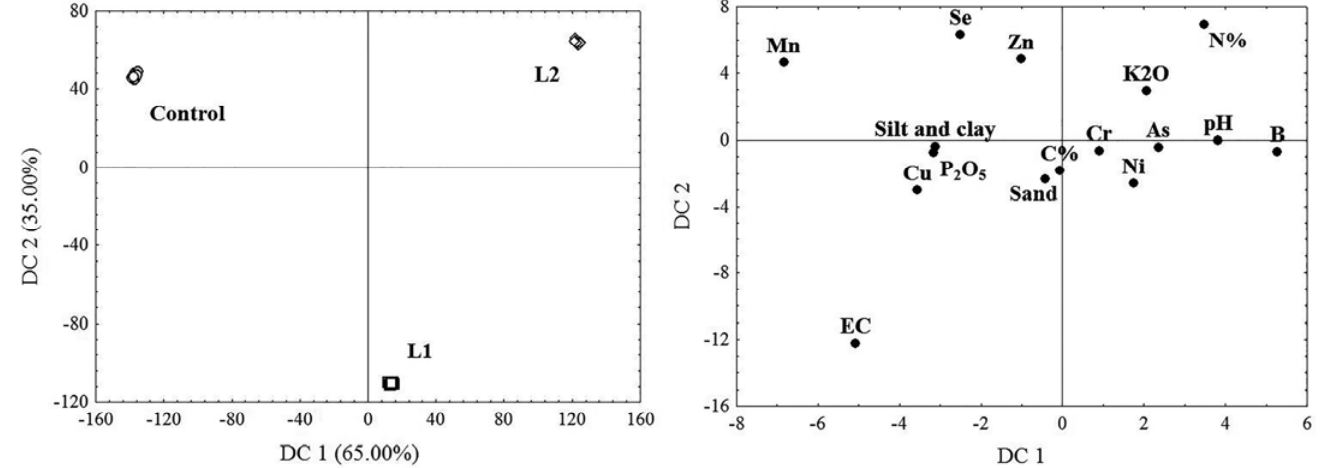
Figure 3. Canonical discriminant analysis (CDA) based on physico-chemical characteristics and pseudo total concentrations of heavy metal(loid)s in FA (L1 and L2) and soil (Control). 2.3. The Physiological and Biochemical Adaptive Response of T. tetrandra to Multiple Stresses from Pollution with Heavy Metal(loid)s in FA sites, analysed according to parameters of chlorophyll fluorescence (Fo, Fm, Fv, F V /F m, Fm/Fo) , metabolites (chlorophylls, total carotenoids, anthocyanins, phenolics Ph Bound and Ph Free and MDA), and total antioxidant capacity (IC 50), is shown in Table 4 and Figure 4. Spearman’s correlations between physiological and biochemical parameters and heavy metal(loid) concentrations in T. tetrandra leaves (CLeaf), is shown in Table 5. The importance of determining the total antioxidant capacity is reflected in the fact that some stress factors cause more pronounced activity of enzymatic components of antioxidant defence compared to non-enzymatic ones [36]. Table 4. The physiological and biochemical response of the leaves of T. tetrandra on fly ash (L1 and L2) and soil (Control).